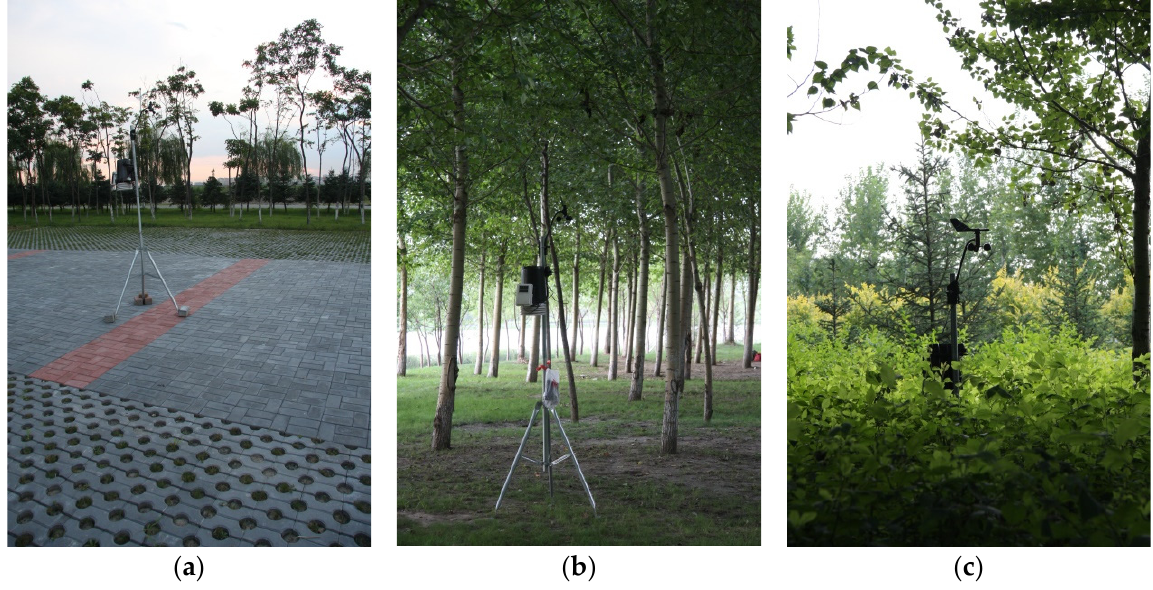
Figure 2. ( a ) The monitoring point of B; ( b ) The monitoring point of TH; ( c ) The monitoring point of TSH (Photos by Haibo Jiang on 23 August